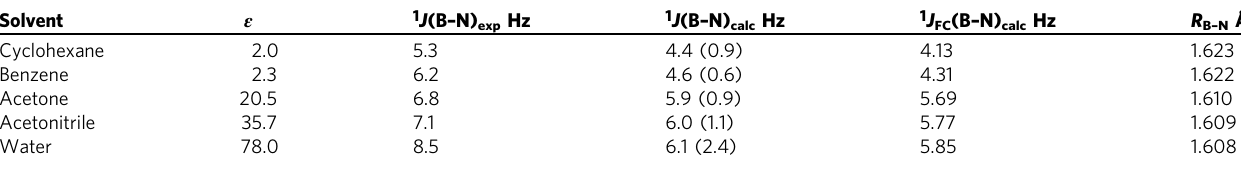
The values are calculated at the PBE0/def2-QZVP level.